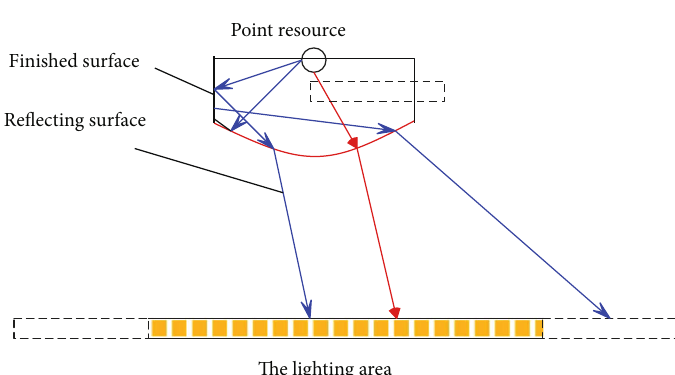
Figure 8: Optical path diagram of secondary recognition visual communication image (DR) in outdoor